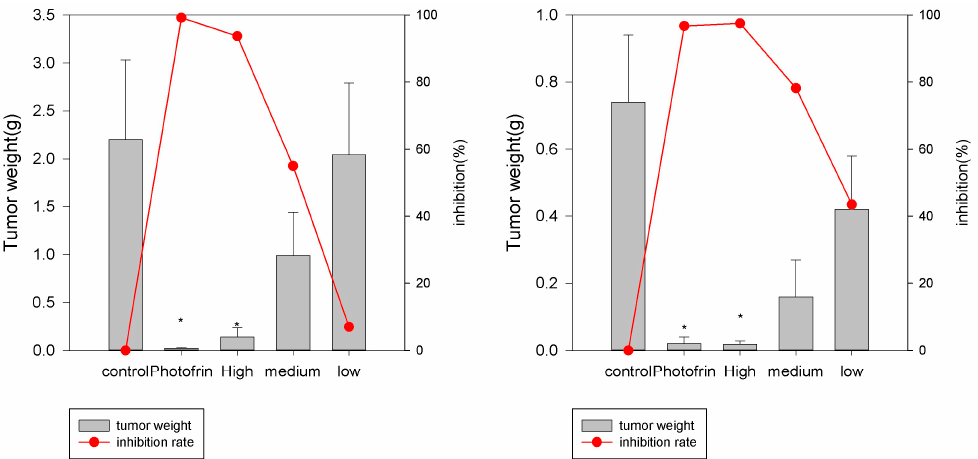
Figure 5. Tumor weights in hepatoma HepG2 xenografts. First experiment ( left ); second experiment ( right ). Control (0.9% NaCl), Photofrin (20 mg/kg); Sinoporphyrin sodium concentration: high dose groups (2 mg/kg), medium dose groups (1 mg/kg), and low dose groups (0.5 mg/kg). * p < 0.05, when compared with control groups.